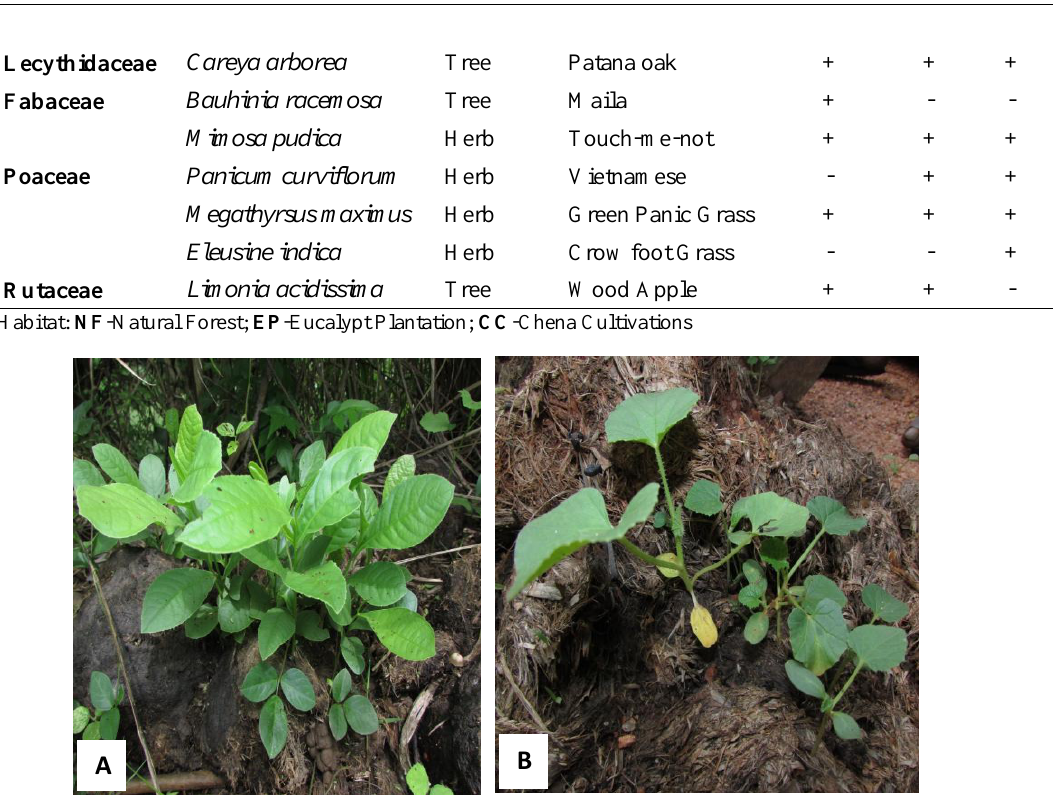
Figure 2 : Germination of Careya arborea ( A ) and Cucumis melo ( B ) from elephant dung